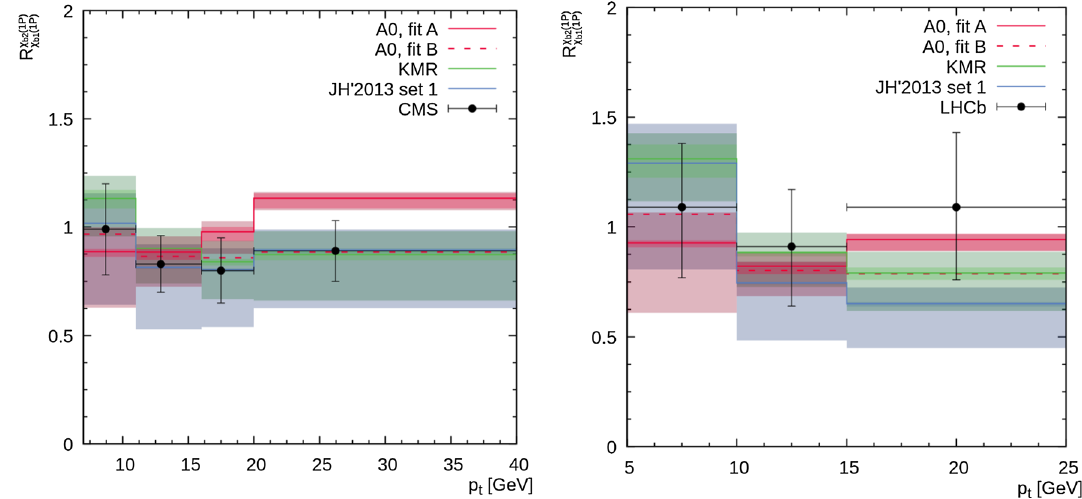
√ s = 8 TeV using the NMEs from Tables 1